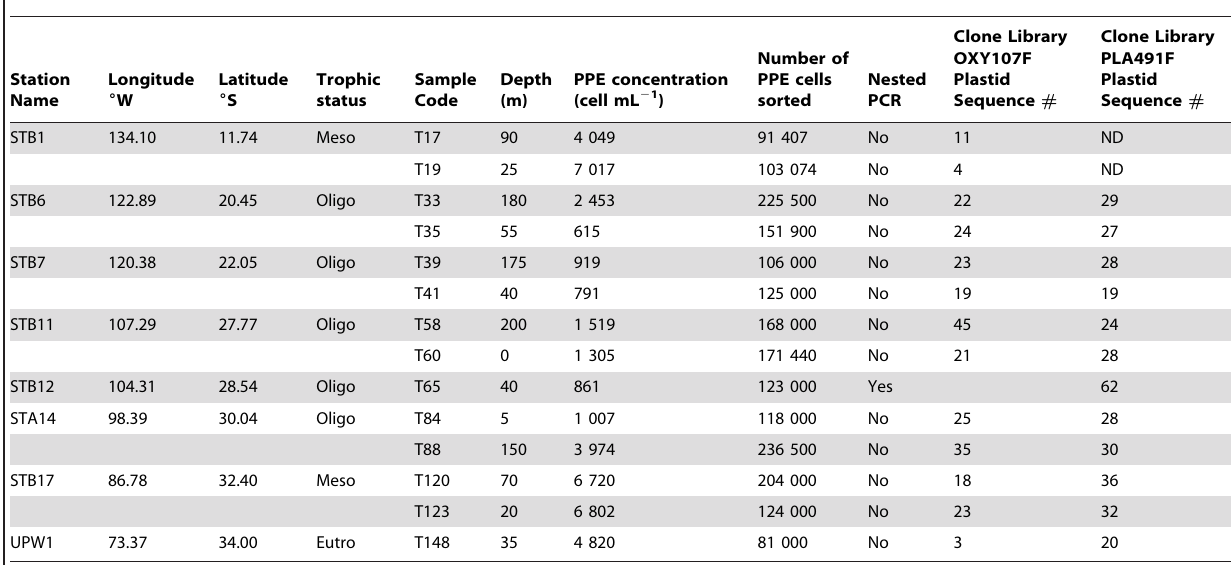
Table 1. BIOSOPE sample locations, Photosynthetic picoeukaryote (PPE) abundance [37], and clone library information.